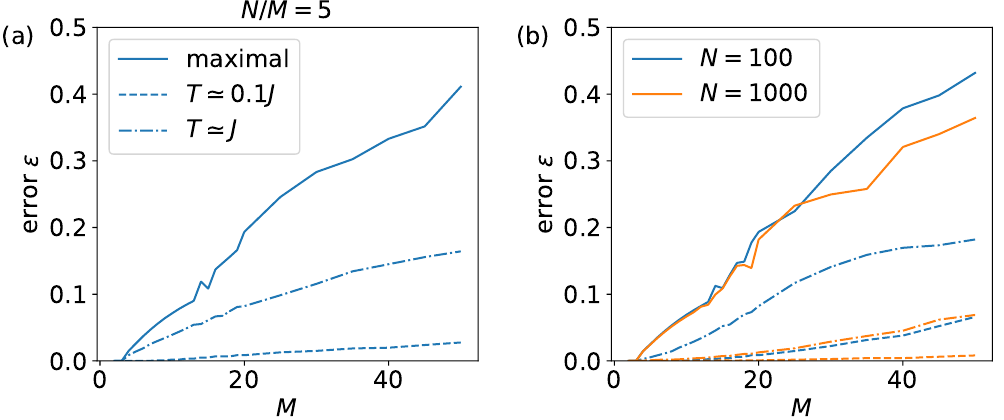
Figure 7: Error (37) as a function of lattice site M . In (a), the filling factor is fixed at N / M = 5. In (b), the particle number N is fixed. The solid lines are the maximal errors, the dashed lines are the errors at T (cid:39) 0.1 J , and the dot-dashed lines are the errors at T (cid:39) J .